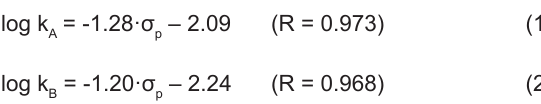
for [2+3] cycloaddition between 1-chloro-1-nitroethene 1 and (Z)-C-aryl-N-phenylnitrones 2a-g p